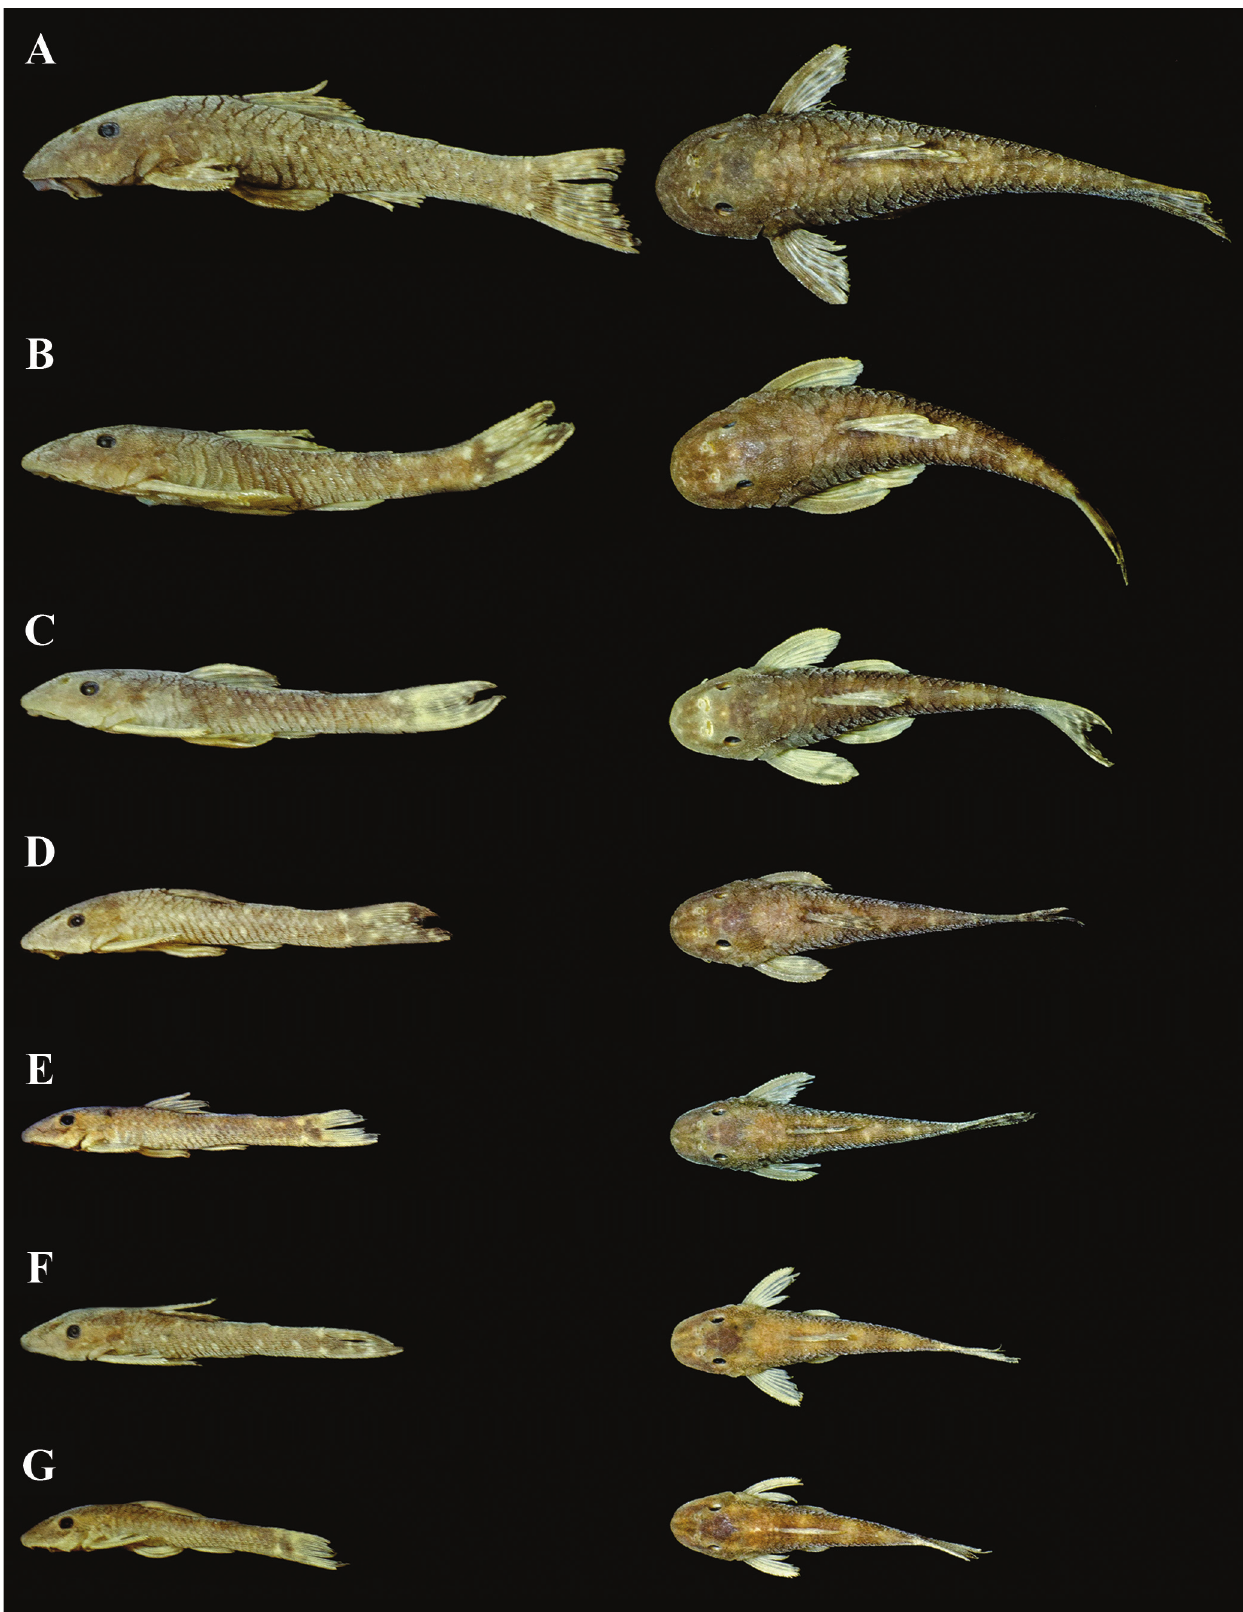
Fig. 3. Ontogenetic variation in Parotocinclus spilurus topotypes, UFRN 0321, 0389, UFPB 9989, specimens A to C between 46.5-30.5 mm SL, D to G between 26.9-21.6 mm SL. Specimens represented in